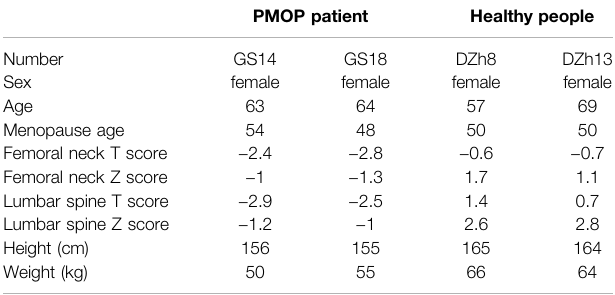
TABLE 1 | Information of clinical